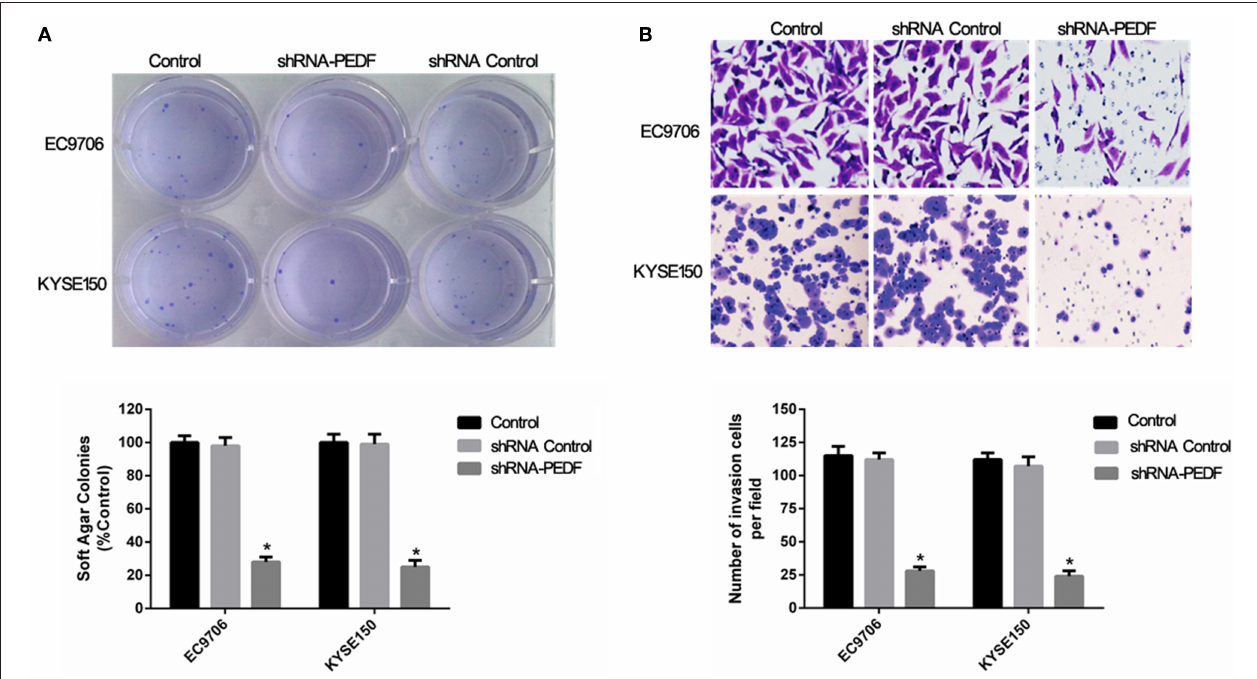
FIGURE 1 | PEDF expression in esophageal squamous cell carcinoma (ESCC). (A) Densitometric analysis was used to quantify the PEDF protein-related bands in Western blotting performed on ESCC and corresponding normal tissues in 40 patients (B) the expression of PEDF in EC9706 and KYSE150 cells after shRNA -PEDF treatment. Left, Western blot result; right, qRT-PCR on mRNA expression of PEDF, as normalized to actin. * < 0.05.